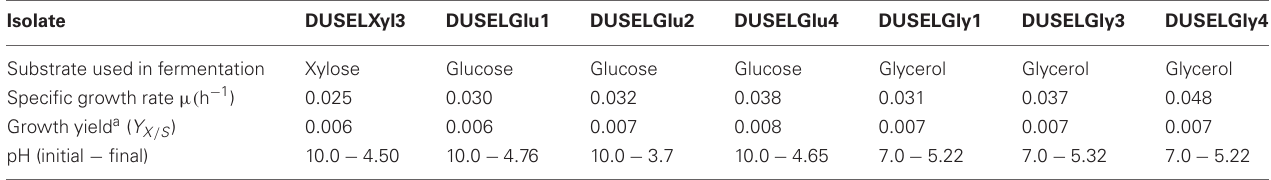
Table 1 | Growth rates and yield coefficients of xylose-, glucose-, and glycerol-fermenting deep-mine isolates. Isolate